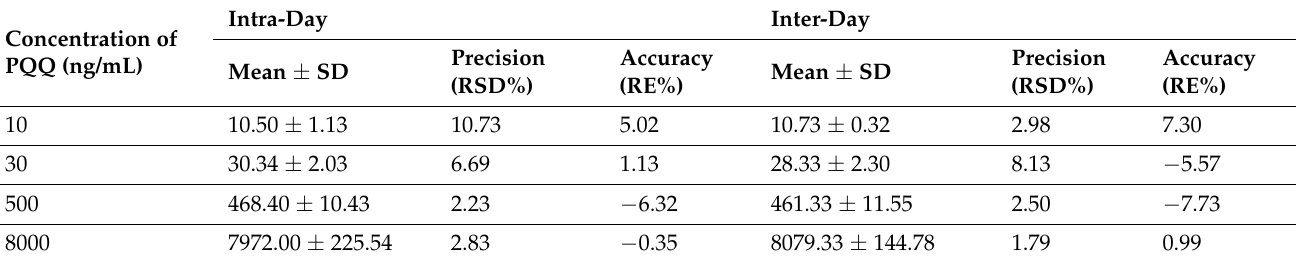
Table 2. Inter- and intra-run accuracy and precision of the method.